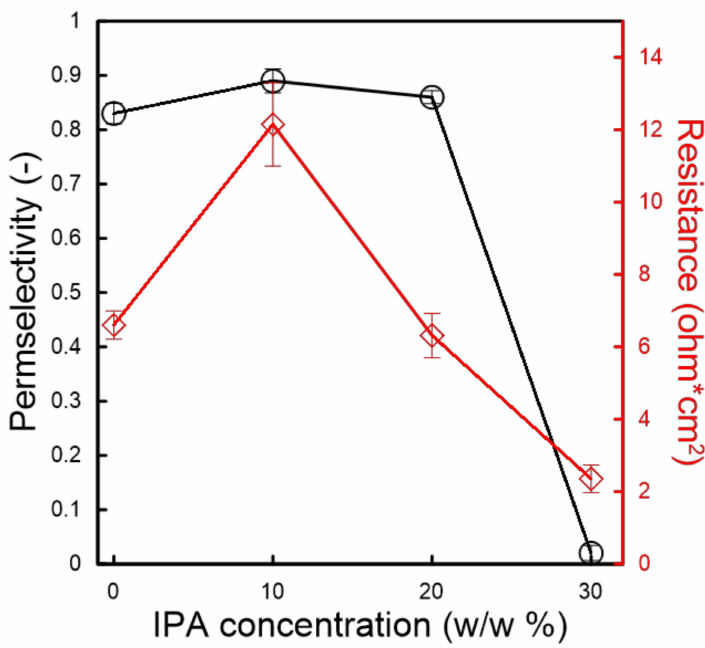
Figure 11. Electrochemical properties of SPSf/(NMP + IPA)